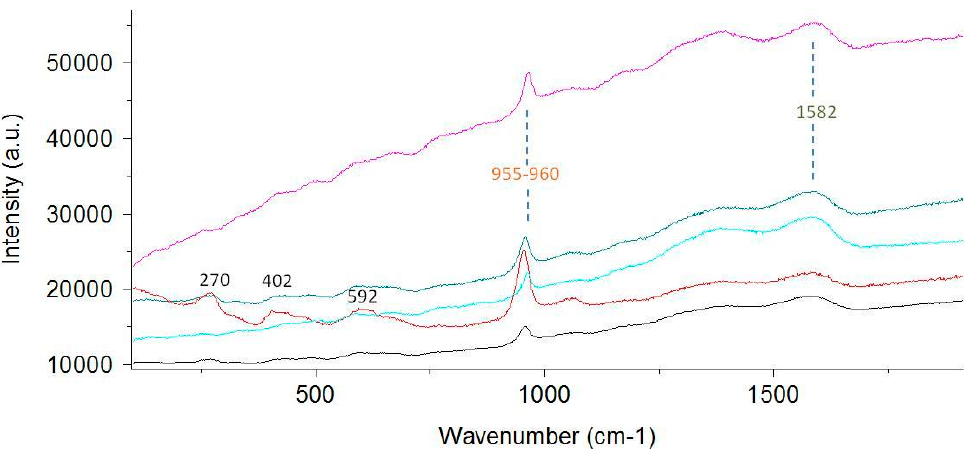
Figure 13. Comparison of Raman spectra from a white spot and from a red part of a single branch of Corallium rubrum from the Mediterranean Sea, all taken with 487.9 nm (Ar + ); (P) stands for polyenes and (C) for calcite.